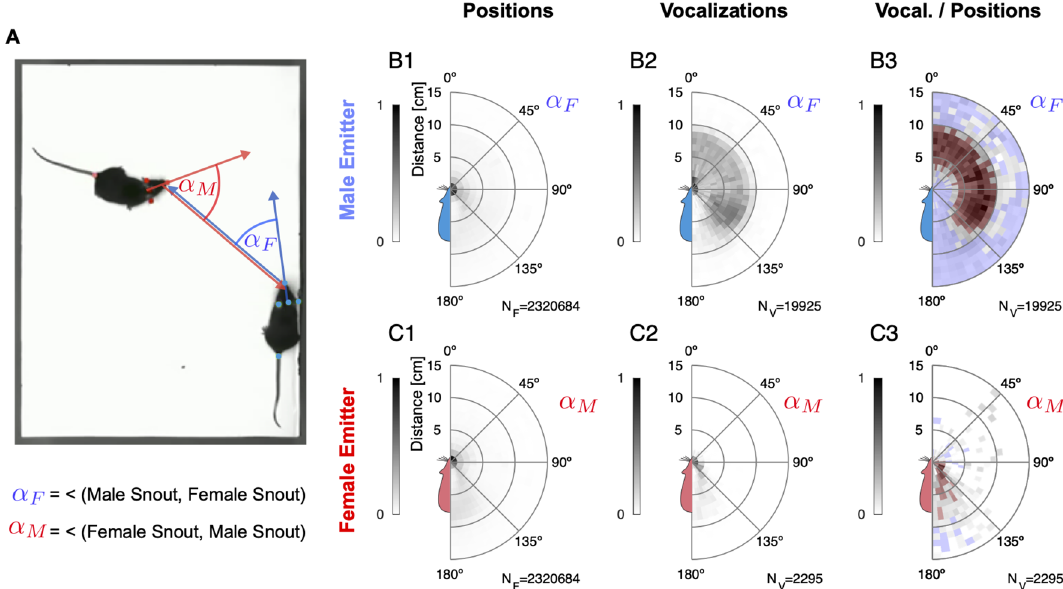
Figure 4. Vocalizations are emitted in particular spatial relationships and differ between sexes. ( A ) The relative position between the mice was analyzed in polar coordinates, with the distance between the snouts and the angle α F/M between the head direction of the emitter and the head position of the receiver. Positive and negative angles (left and right side of the emitter mouse) are mirrored and averaged. ( B 1) First, the video data was used to establish the vocalization-independent spatial location prior distribution as an average across all video frames (N = 2.3 M). The female mouse was most frequently in facing, snout-to-snout contact with the male mouse (peak near 0° and 0–2 cm). In ( B and C ) the shades of gray display peak-normalized histogram entries. In B3/C3 the color (red / blue) indicates significance. N F indicates the number of video frames. ( B 2) USVs were emitted by the male mouse both in snout-to-snout contact but also very frequently when the female snout was about 5–10 cm away, which largely corresponds to snout-to-ano-genital contacts. N V indicates the number of vocalizations. ( B 3) After normalizing by the relative position prior, ( B 1) USVs emitted in snout-to- ano-genital location were the most abundant in the sense of a high conditional probability whereas snout-to- snout vocalizations in fact occur relatively infrequently. The color red / blue indicates that for this particular relative position the male mouse was vocalizing significantly more / less than one would expect based on the prior. ( C 1) The male mouse was also predominantly in facing, snout-to-snout contact but also spent substantial amounts of time near the anogenital of the female mouse (light-maroon density between 140–180° and 5–8 cm). ( C 2) Female mice vocalized when the male was in snout-to-snout contact or behind/to the side of the female mouse. ( C 3) After normalizing by the relative position prior ( C 1), the most frequently encountered positions for females were the snout-to-snout, snout-to-ano-genital (male at anogenital of female mouse), but also more distant relative overlap (compare Fig. 4B,C3; p < 0.05 for all bins, permutation test against spatially shuffled density values, red/ blue hues indicate significant positive/negative deviation, respectively). In summary, male and female mice exhibit substantial preferences in when they choose to vocalize during dyadic courtship interactions, male mice predominantly during snout-to-anogenital proximity, and females dur- ing snout-to-snout proximity. These salient differences in relative spatial position during vocalization between the sexes are likely mediated by behavioral contexts that present different motivational cues, e.g. tactile or olfactory. Relative position during USV production shapes USVs properties for both strains and sexes. Exploiting the combination of high-accuracy localization of animals and vocalizations, we explored the influence of relative position, genetic variant and sex on the USV properties emitted by the mice (Fig. 5, and Supplementary Fig. 4, respectively). Below, significances across groups (sexes/strains) are based on a 3-way, nested ANOVA analysis, with the predictors sex, genetic variant, and individual animal, where the latter was nested w.r.t. the first two; significances across angles/distances and within group (sex/strain) on Kruskal–Wallis one-way ANOVAs; significances across group and angles/distances on regular 2-way ANOVAs (due to unavail- ability of a general, non-parametric 2-way test). All p -values and effect sizes (Cohen’s D ) are reported in Fig. 5. We collected the average properties of USVs emitted by a given group in relation to the interacting group at the time of vocalization in a combined color-density plot (Fig. 5, top two rows). In these plots, the intensity indi- cates the density of occurrence of USVs in the relative spatial bin while the color hue indicates the property value, e.g. a USV’s duration. More intense colors thus also correspond to more reliably estimated means in this location. The duration of USVs emitted by Foxp2-R552H was significantly shorter (Fig. 5A, Foxp2-R552H (orange): 54 ms, WT (blue): 66 ms, p = 2.6 × 10 −10 ). In addition, the duration of USVs decreased with angle from front to back ( p < 10 −3 for both) and with snout-to-snout distance for both groups ( p < 10 −3 for both) and differed